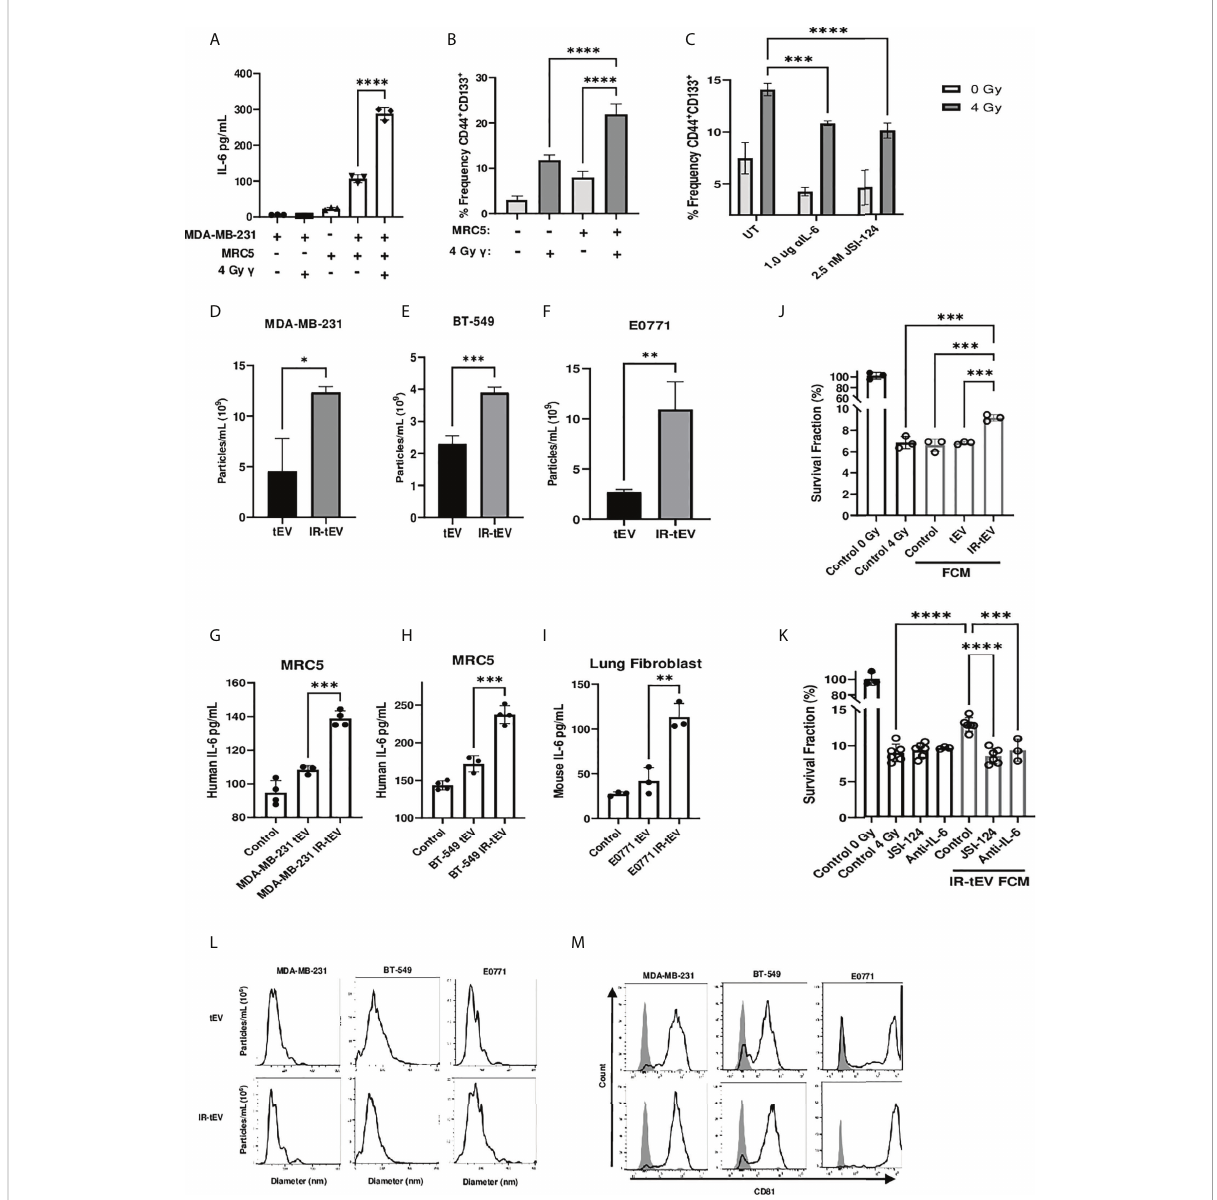
FIGURE 1 IR-tEV stimulate pro-tumor fi broblast activity. (A) MDA-MB-231 breast cancer cells were cocultured with fi broblasts. IL-6 expression was measured via ELISA (A) and CD44 and CD133 expression levels were quanti fi ed via fl ow cytometry (B, C) MDA-MB-231 cocultured with MRC5 cells with or without anti-IL-6 antibody or JSI-124. CD44 and CD133 expression were quanti fi ed via fl ow cytometry. Statistical signi fi cance for (A-C) assessed with ANOVA * = P < 0.05. (D-F) Human or mouse tEVs were collected from breast cancer cell conditioned media before or after exposure to 4 Gy or 10 Gy gamma radiation, respectively. Total particle number was assessed via particle tracking with the Zetaview Particle Tracker. (G-I) Fibroblasts were incubated with breast cancer cell line tEV or IR-tEVs as indicated. IL-6 levels were measured via ELISA. Statistical signi fi cance for (D-I) was assessed via students T test. * = P < 0.05. (J) Irradiated MDA-MB-231 were exposed to fresh media containing FCM described in (G) and radioresistance was assessed via clonogenic assay. X axis indicates which FCM from (G) was used in the incubation. (K) MDA-MB-231 were exposed to fresh media containing IR-tEV stimulated FCM described in (G) , in the presence or absence of STAT3 activation inhibitor or IL-6 neutralizing antibody, and radioresistance was assessed via clonogenic assay. Statistical signi fi cance for (J, K) was assessed with ANOVA * = P < 0.05. (L) The size distribution of tEVs collected from irradiated and untreated breast cancer cells was assessed via particle tracking with the Zetaview Particle Tracker. (M) Expression of the exosomal marker CD81 was assessed via bead assisted fl ow cytometry. ** denotes a P value < 0.005. *** denotes a P value < 0.0005. **** denotes a P value < 0.00005. These values were the results of ANOVA analyses performed on